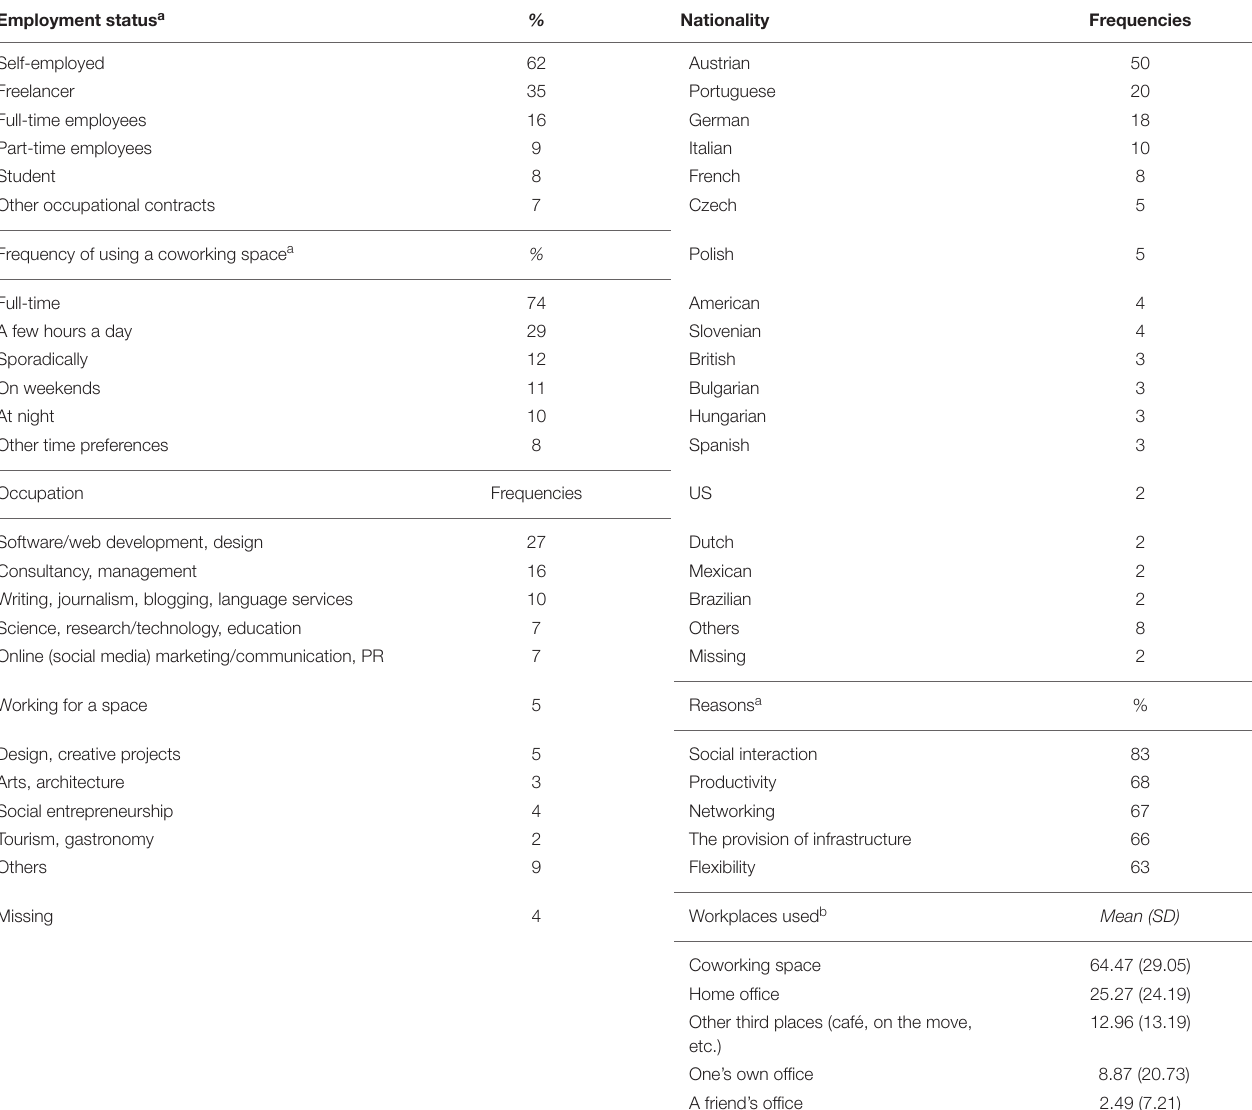
TABLE 1 | Sample characteristics of the coworking